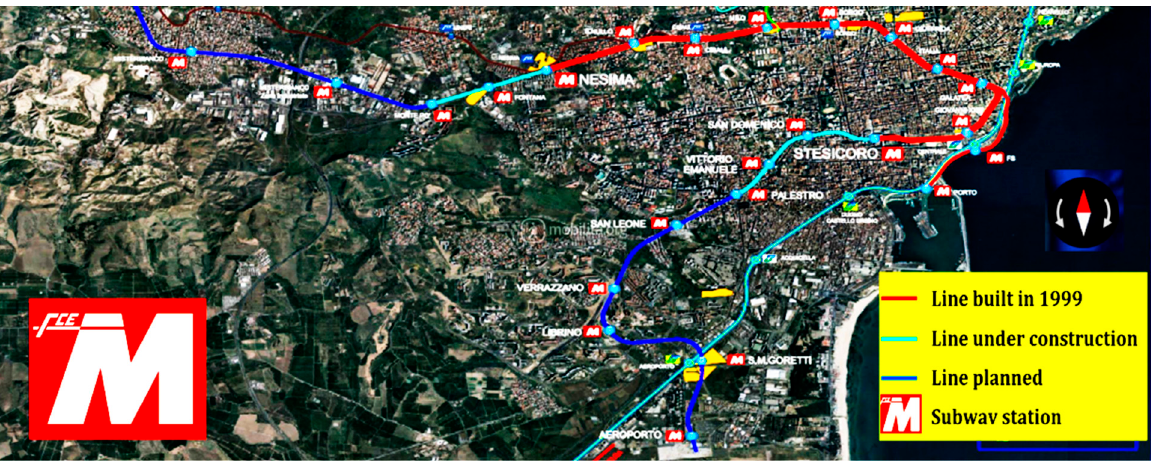
Figure 1. The underground network in Catania (modified from https://catania.mobilita.org/opere/metropolitana-di-catania-storia-e-sviluppi-futuri/, accessed on 1 September 2021).